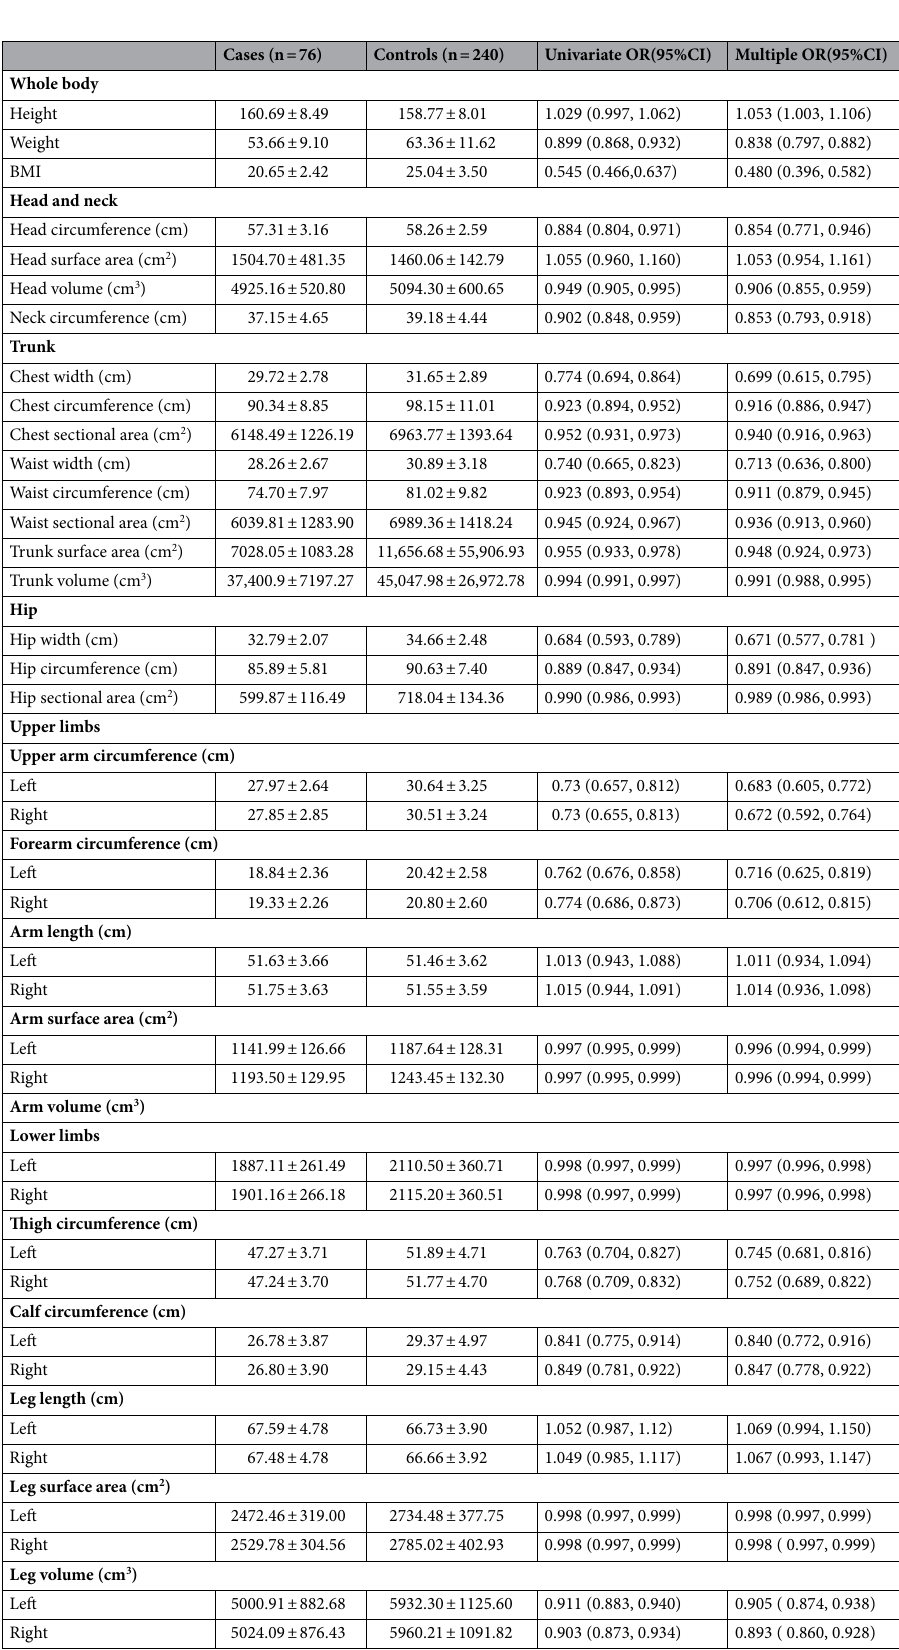
Table 2. Descriptive statistics of 3D surface body measures between participants with sarcopenia/ presarcopenia and